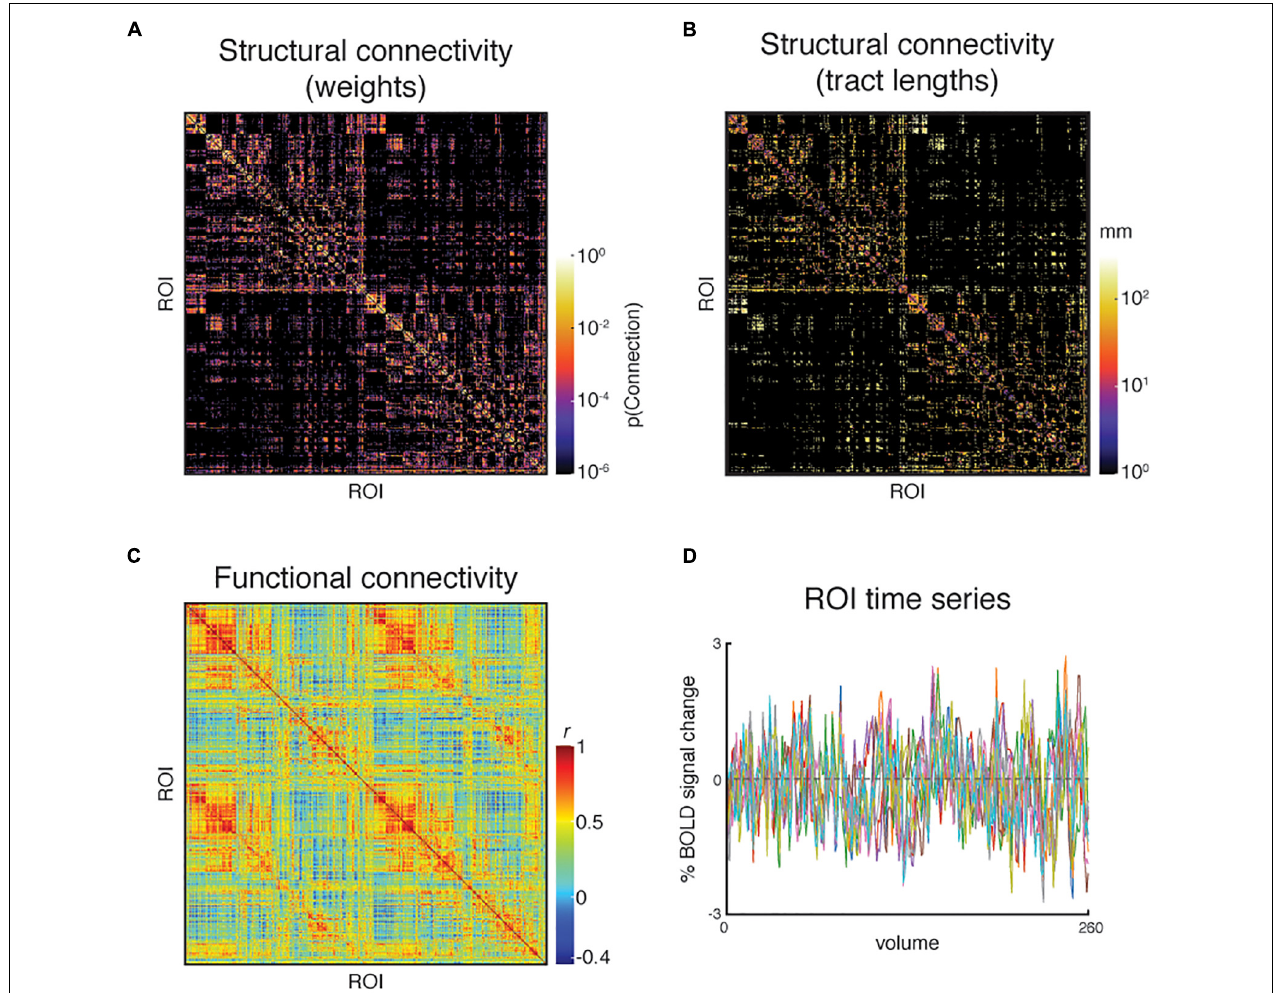
FIGURE 6 | An example subject’s set of pipeline outputs for connectome-based modeling. These include (A) a weights matrix and (B) a tract lengths matrix from dMRI processing that capture the subject’s structural connectivity; (C) a functional connectivity matrix of Pearon correlation coefficients, and (D) the region of interest (ROI) time series from resting-state fMRI processing. The structural connectivity matrices are presented on a log scale to enhance readability. Ten ROIs were chosen randomly for presentation in panel (D)